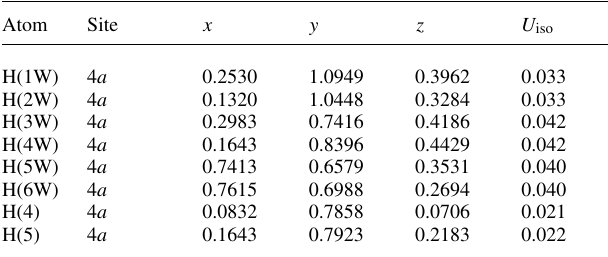
Table 2. Atomic coordinates and displacement parameters (in Å 2 ) .